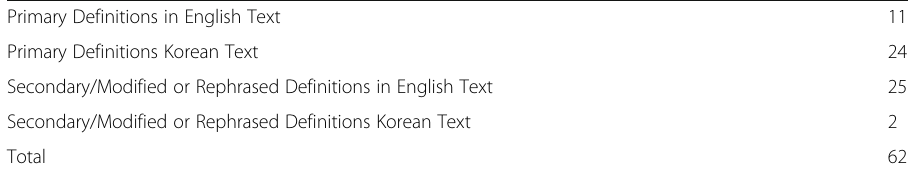
Table 4 Number of primary and secondary/modified definitions